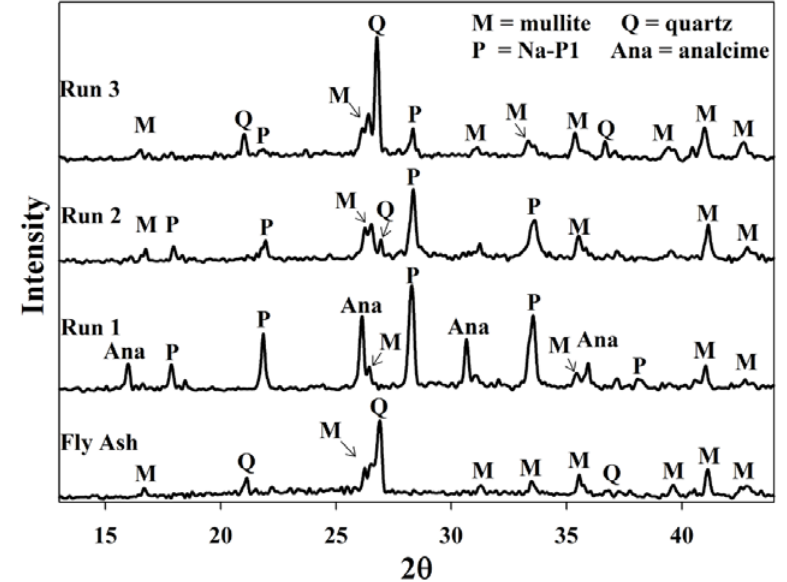
Figure 2. Powder X-ray diffraction patterns of products obtained after recycling waste supernatant back into the system as a NaOH source without a prior pH adjustment of the waste. Run 1 Baseline run using fresh NaOH solution. Run 2 synthesis using waste supernatant from Run 1 as NaOH source. Run 3 synthesis using supernatant waste from Run 2 as NaOH source.